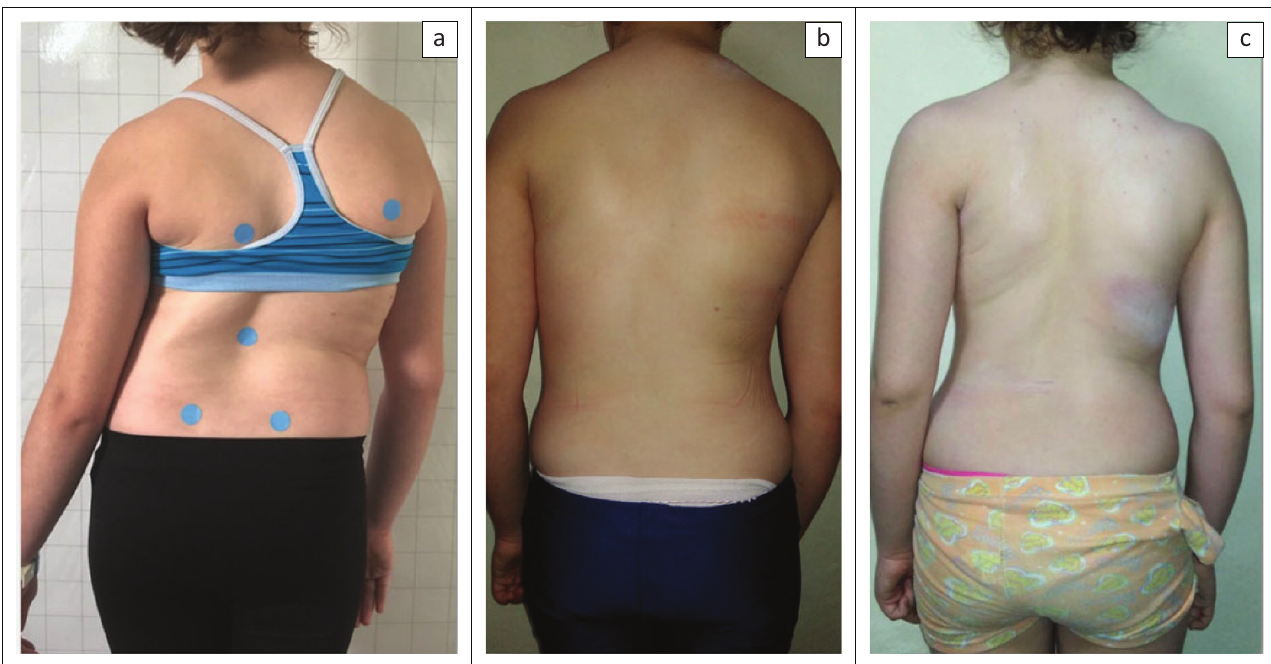
FIGURE 4: Clinical aspects of the patient during the follow-up. (a) Initial finding (November 2019), (b) intermediate result with pelvic prominence to the right indicating a clinical 4C pattern and (c) clinical result of the patient at Risser 2 prior to application of the third brace (2/2021).